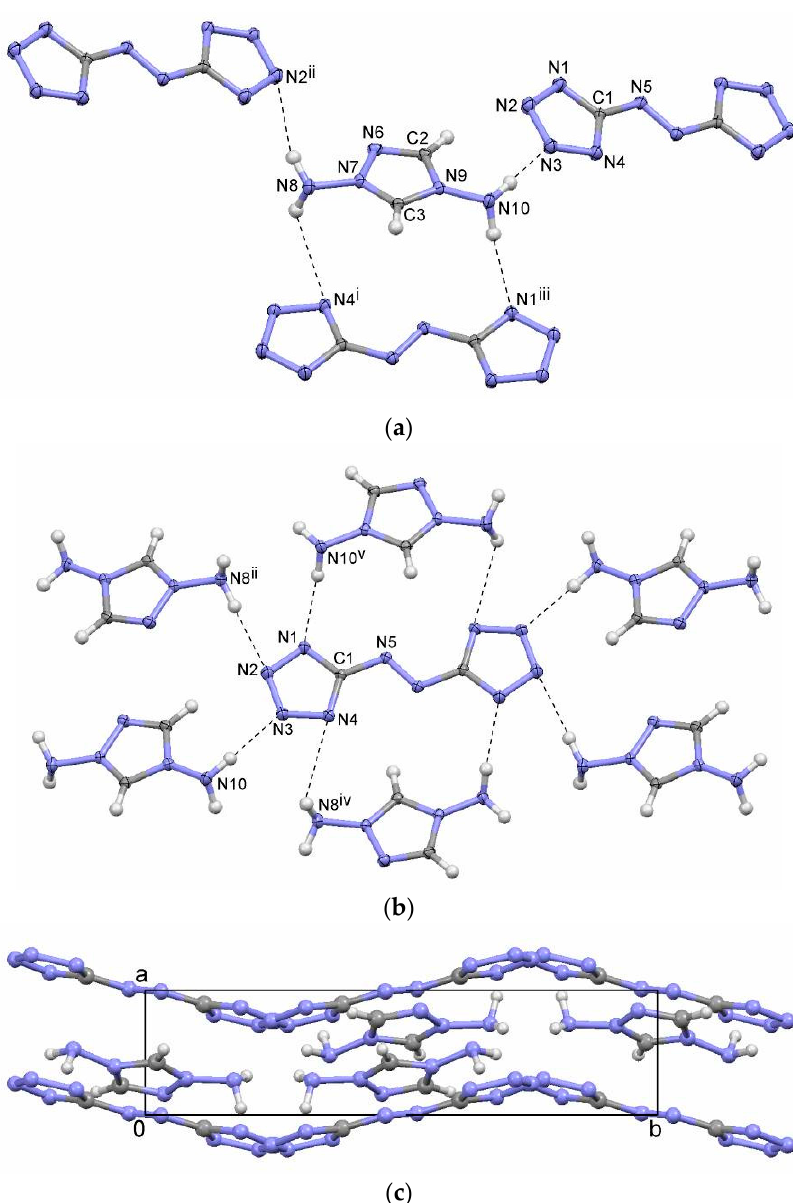
Figure 3. Bis(1,4-diamino-1,2,4-triazolium)5,5'-azotetrazolate ( 2 ). ( a ) The cation as hydrogen-bond donor; ( b ) The anion as hydrogen-bond acceptor; ( c ) Wave-like arrangement of the ions in the unit cell. Symmetry codes: (i) – x , –1/2 + y , 1/2 – z ; (ii) 1 – x , 1 – y , 1 – z ; (iii) x , 3/2 – y , –1/2 + z ; (iv) – x , 1/2 + y